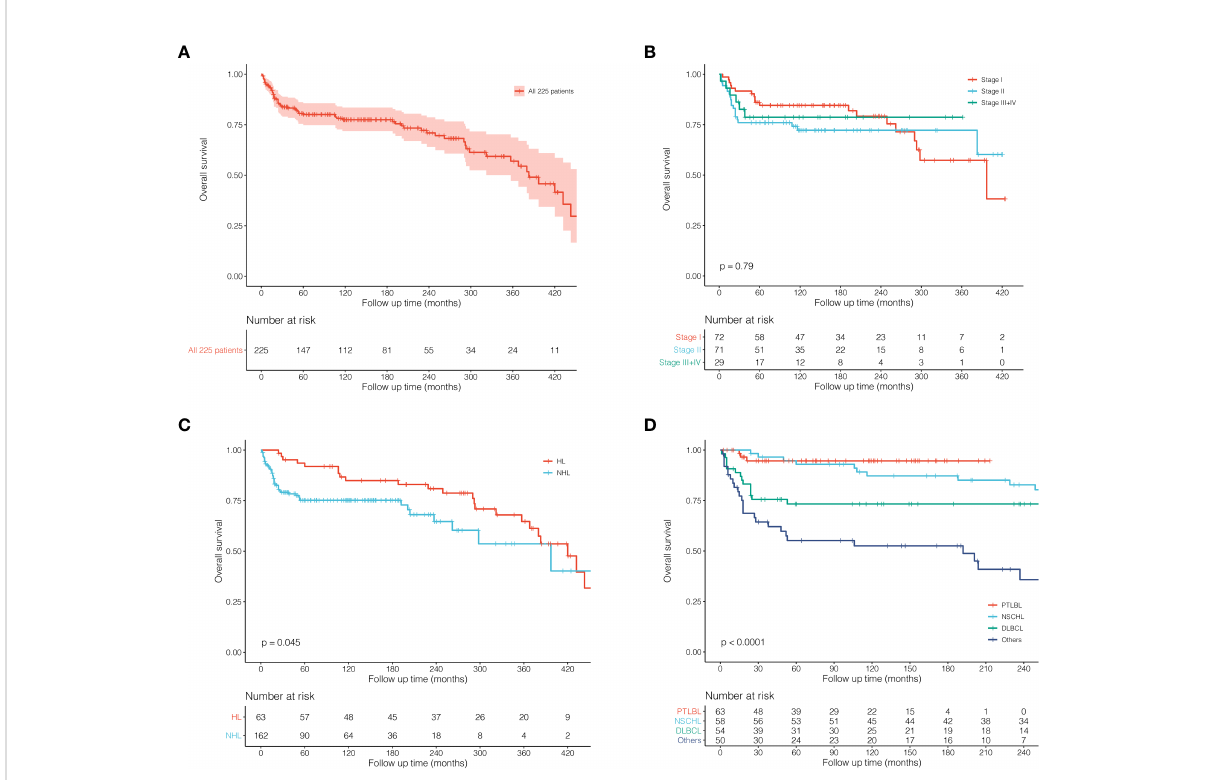
FIGURE 2 Kaplan – Meier survival curves and log-rank tests for 225 patients with thymic lymphoma from the SEER Research Data with 9 Registries (1975 – 2018). (A) KM survival curves of all 225 patients. (B) KM survival curves grouped by Ann Arbor stages. (C) KM survival curves grouped by HL and NHL. (D) KM survival curves grouped by histological classi fi